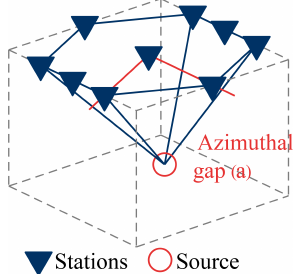
Figure 9. Placement of the nine stations used as receivers for test- ing the influence of stations that are heterogeneously distributed. The maximum azimuthal gap ( a ) is the largest angle found between two stations viewed from the centre station. The azimuthal gap was increased by moving the corner stations closer to the side receivers on two